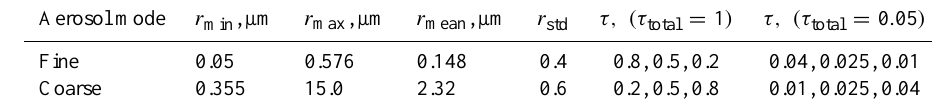
Table 2. Parameters of log-normal distributions used for aerosol size distribution modelling. Aerosol mode